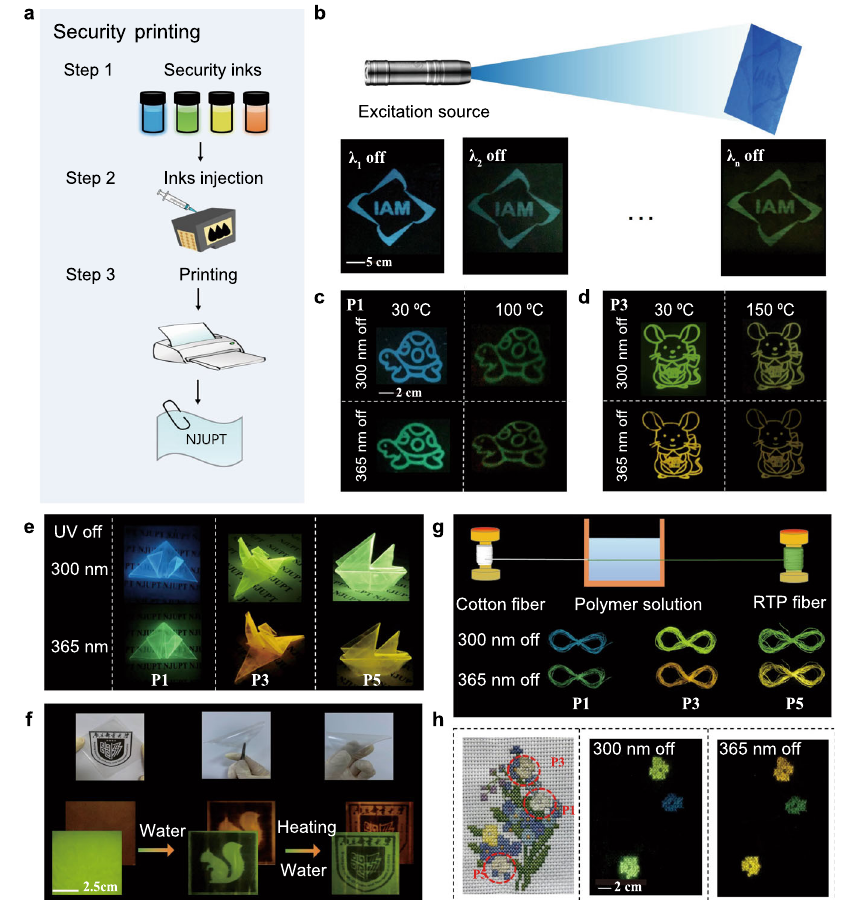
Fig. 5 | Transparent fi lms and cotton fi bers with Ex-De afterglow